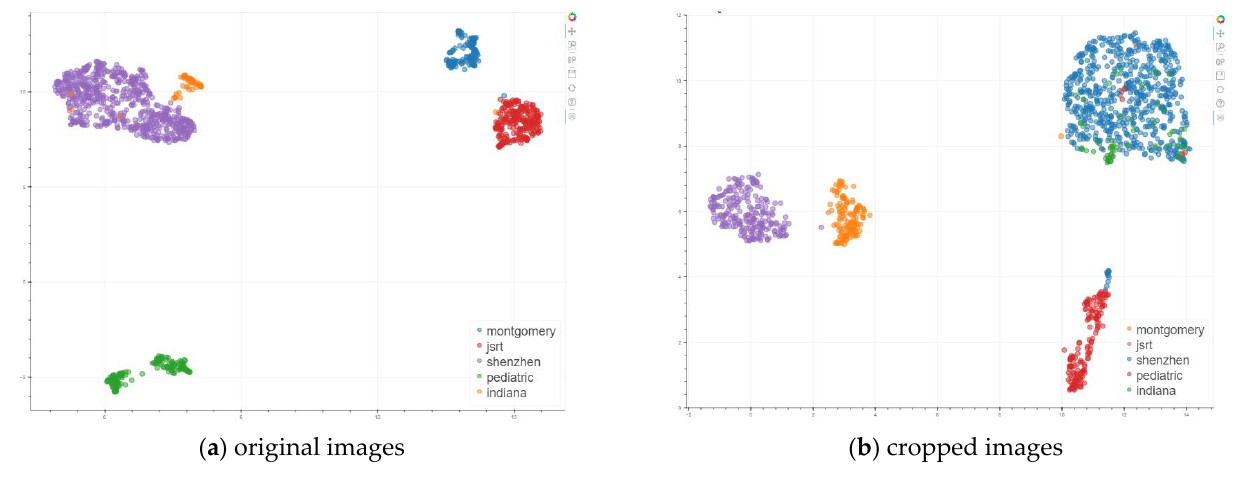
Figure 4. UMAPs of ImageNet Swin-B classification model features extracted from ( a ) original and ( b ) cropped images.